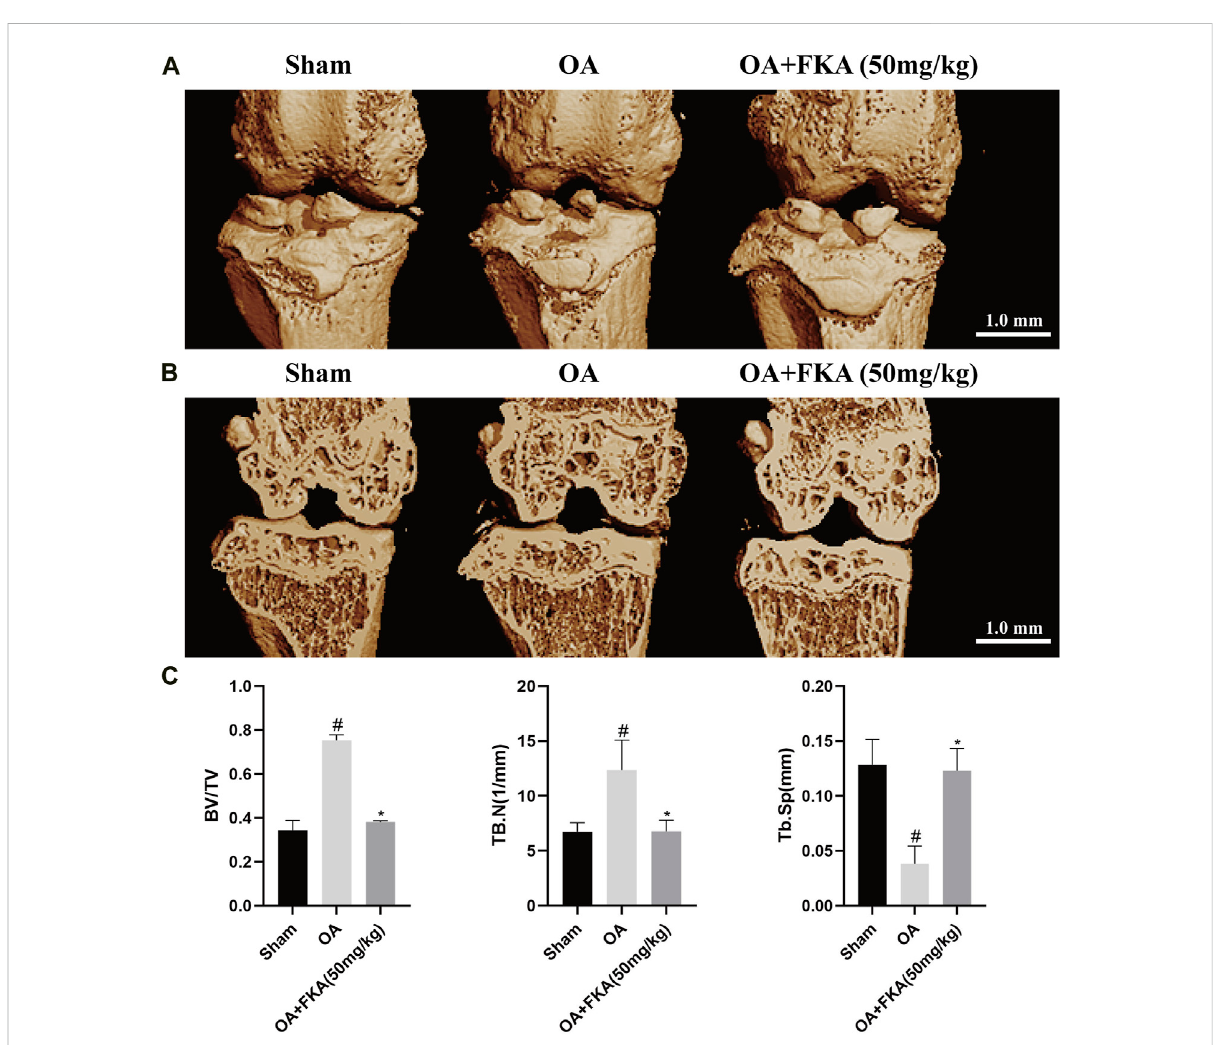
FIGURE 10 Micro-CT evaluation of the impact of FKA on subchondral bone remodeling in the mouse OA model. (A) 3D image of mouse OA model generated by micro-CT scan. (B) Coronal image views oftherightknee fromthe sham, OA, and OA+ FKA group mice. (C) BV/TV, Tb.N, and Tb.Sp of the three groups. * p < 0.05 and ** p < 0.01 vs sham group (scale bar 1